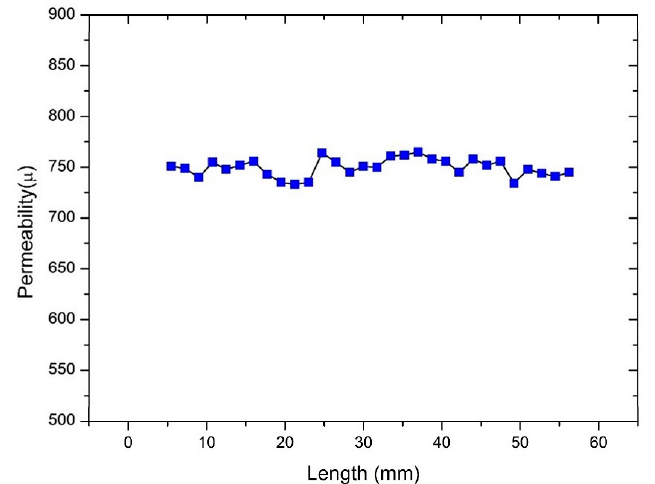
Figure 3. Permeability distribution in low carbon steel coupon (arbitrary units), measured before the treatment, corresponding to a rather homogeneous stress distribution along the centerline.